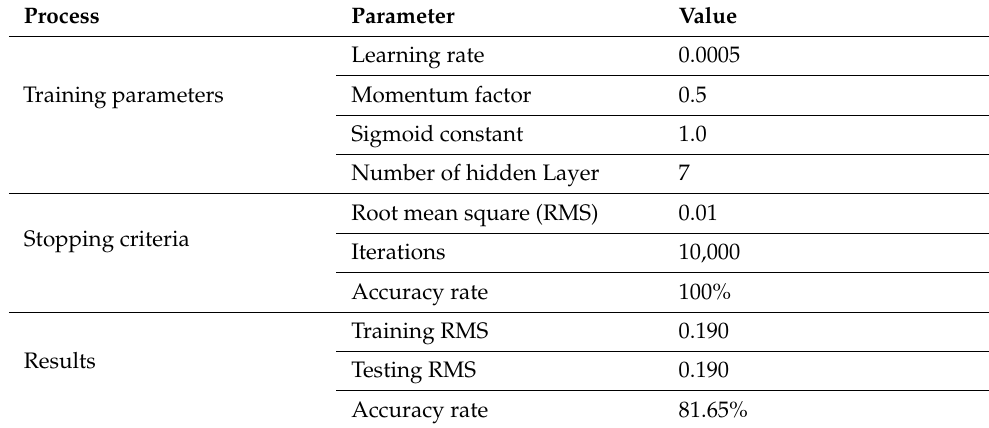
Table 2. MLP running parameters and simulation results from